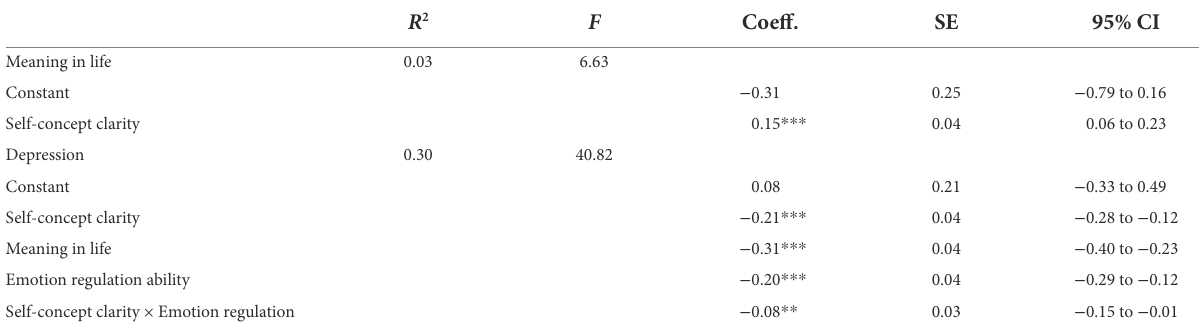
TABLE 2 Coefficients for the tested moderated mediation model ( N =